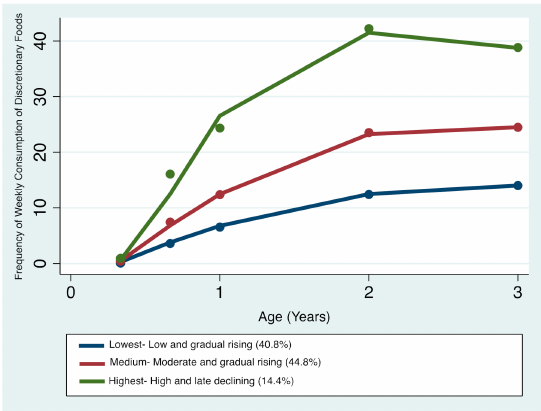
Figure 2. Trajectories of discretionary foods consumption in infancy and early childhood.